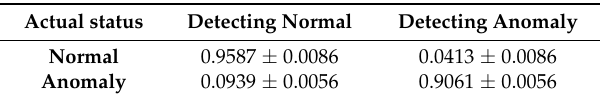
Table 6. Performance of the estimation-based model.